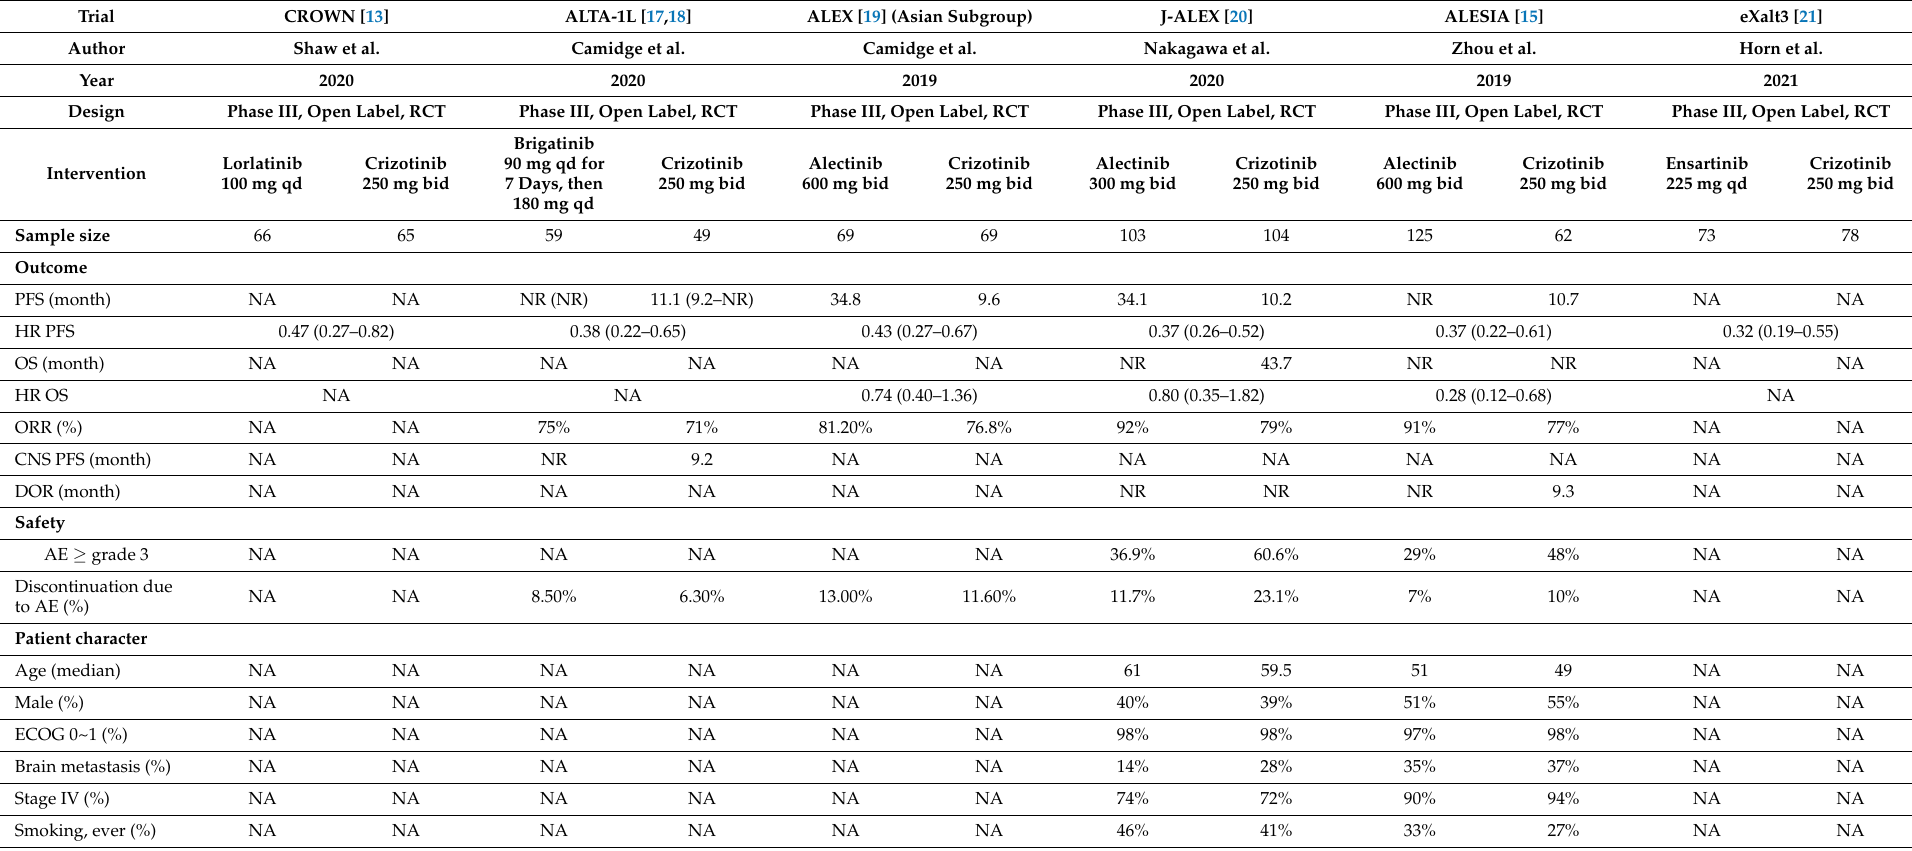
Table 1. Characteristics of the included studies of first-line ALKI treatment for advanced ALK-positive NSCLC in the Asian